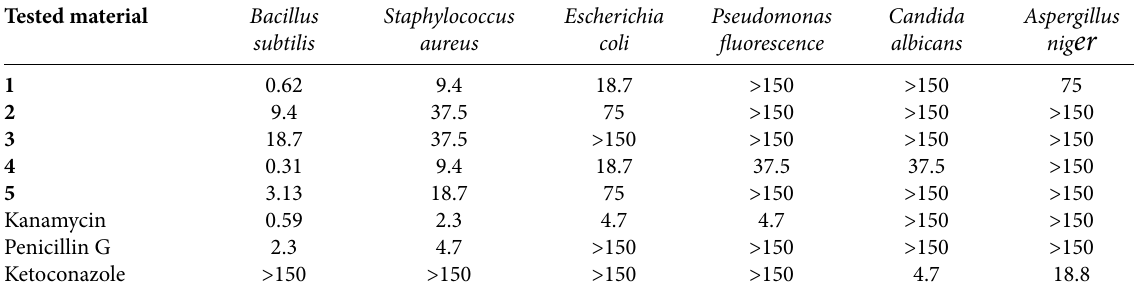
Table 4. The MIC values (μM) of the compounds 1 – 5 Tested